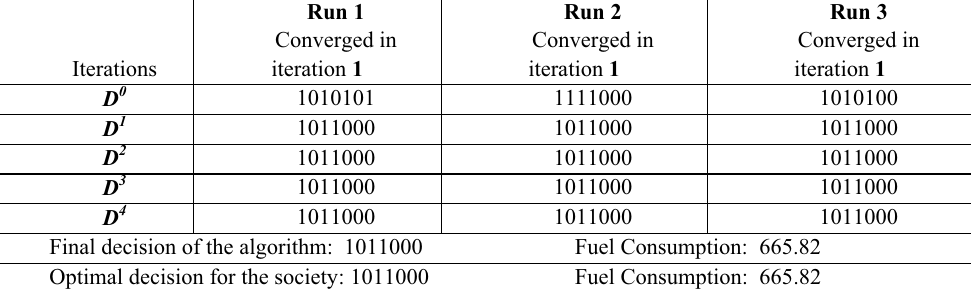
Table 4. Progress of the proposed algorithm for first set of fuels in problem case 2 in three different runs.